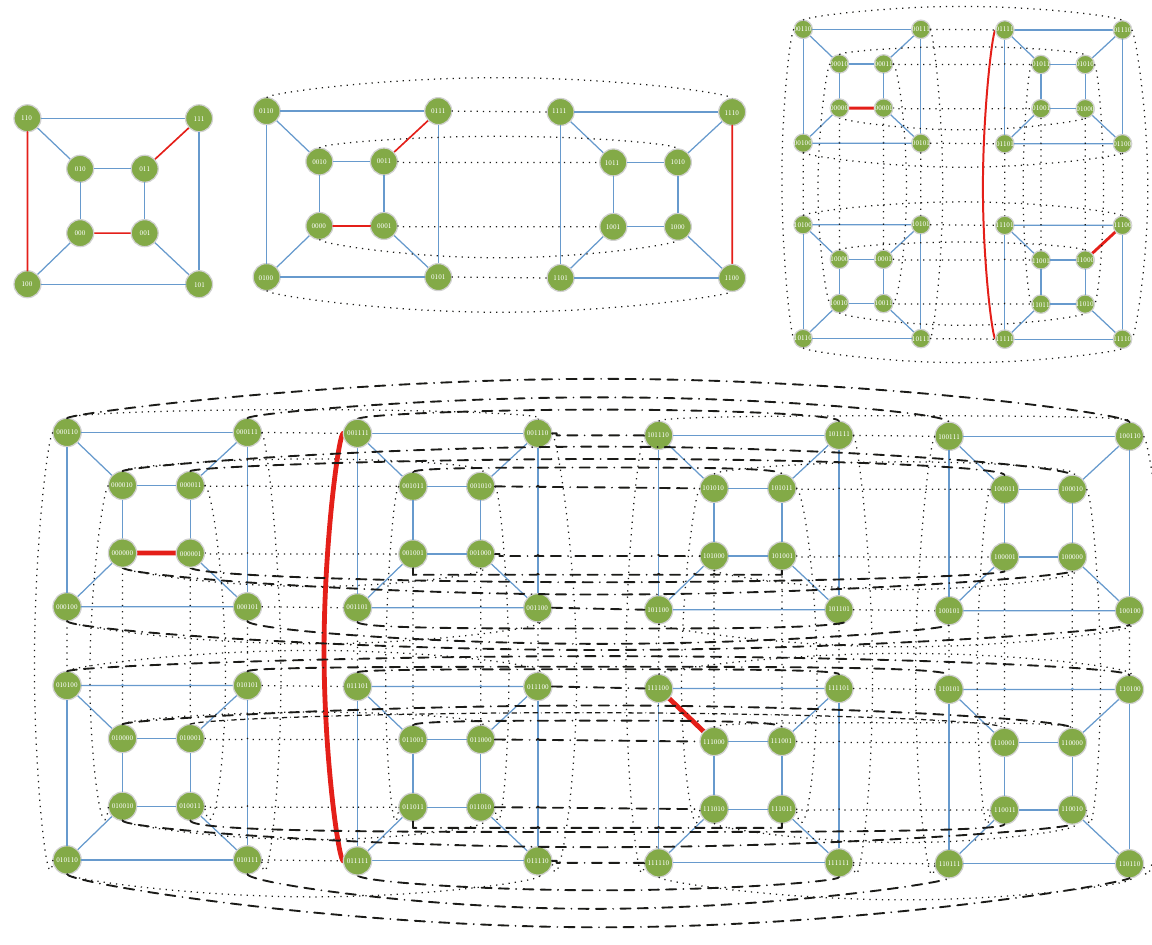
Figure 5: The proposed candidate in 𝐻 𝑛